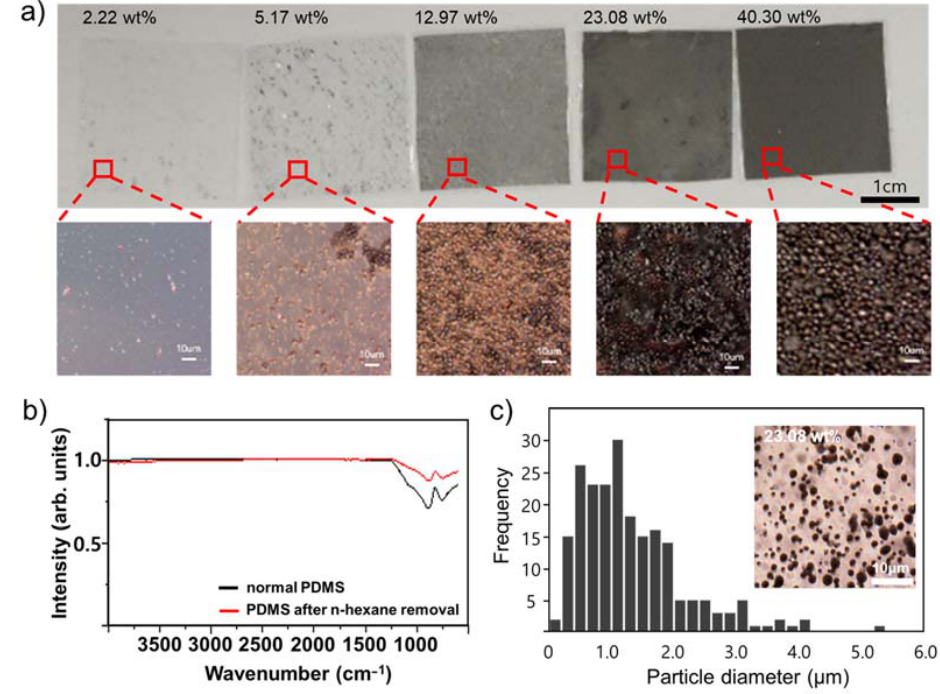
Figure 2. ( a ) Optical images of LM/PDMS dielectric film with weight percentages of 2.22 wt.%, 5.17 wt.%, 12.97 wt.%, 23.08 wt.%, and 40.30 wt.%, along with magnified images of each film. ( b ) FT-IR absorption spectra of 23.08 wt.% LM/PDMS film and normal PDMS film after thermal curing process. ( c ) Particle size frequency distribution curve analyzed through optical imaging of the 23.08wt.% LM/PDMS film.